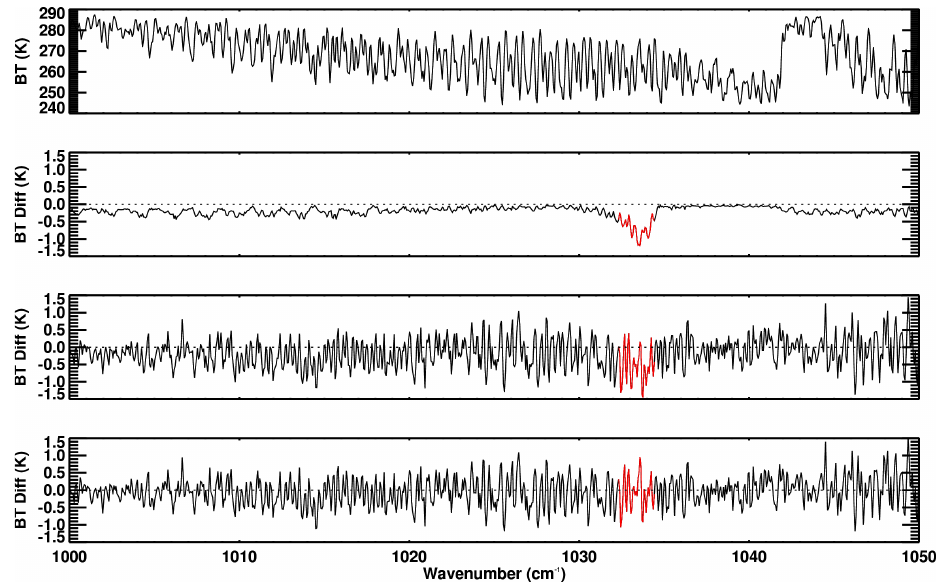
Fig. 5. Sample TES methanol measurement over central Canada (59.34 ◦ N, 106.52 ◦ W) on 23 June 2008, which coincided with the second phase of the NASA ARCTAS campaign. Top panel: spectral brightness temperature observed by TES. Second panel: CH 3 OH signal, obtained by differencing third and fourth panels. Third panel: measurement-model residuals based on the initial guess methanol profile. Fourth panel: measurement-model residuals following the methanol retrieval.